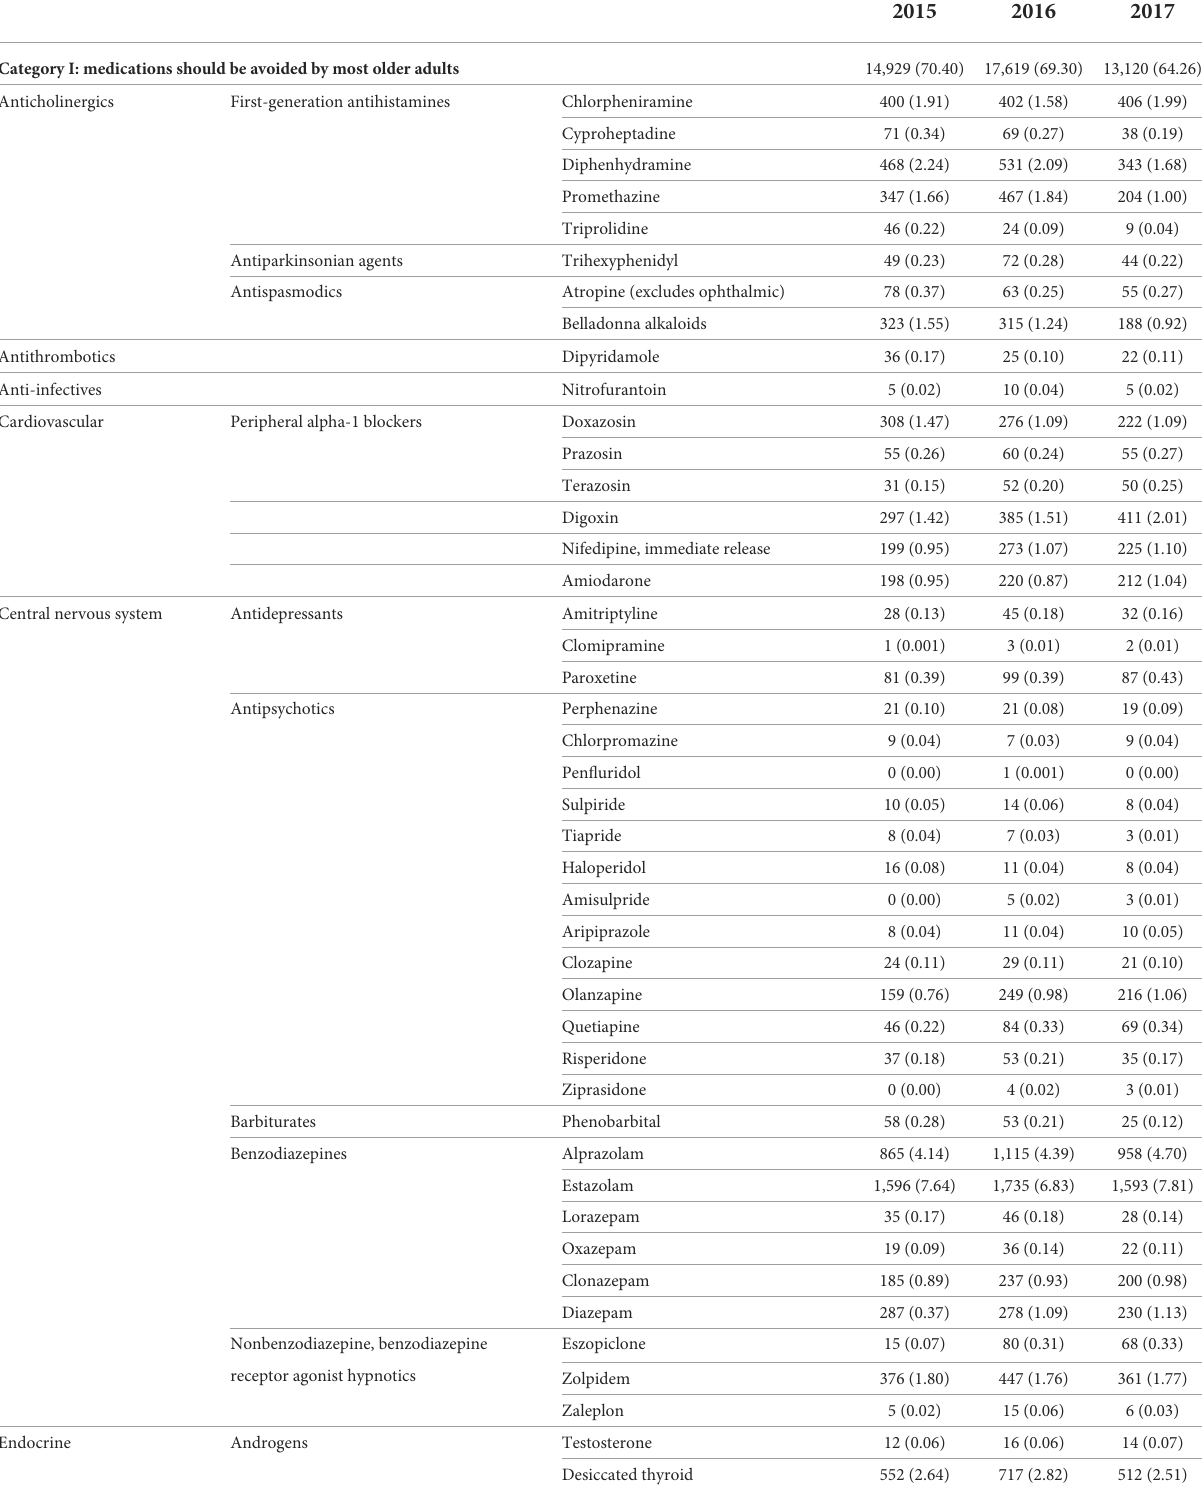
TABLE 3 Prevalence of PIMs by Beers category, drug class and medications of older adults with diabetes in 2015, 2016, and